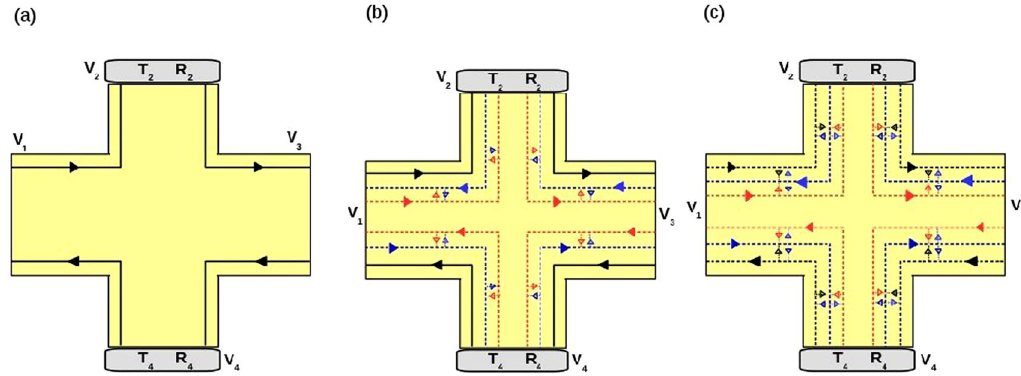
Figure 2. Four terminal quantum anomalous Hall bar showing chiral QAH and quasi-helical QSH edge modes. ( a ) Topological QAH edge mode with disorder at probes 2 and 4: R 2 , T 2 and R 4 , T 4 represent the reflection and transmission probability of edge modes from and into contact 2 and 4 respectively, ( b ) Topological QAH edge mode with quasi-helical edge modes: Disordered probes 2 and 4, ( c ) Trivial QAH edge mode with quasi-helical edge modes: Disordered probes 2 and